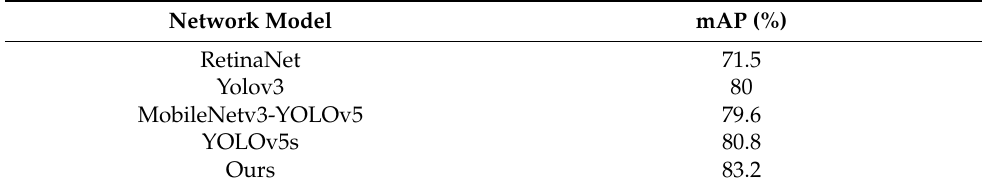
Table 7. Performance comparison on different network